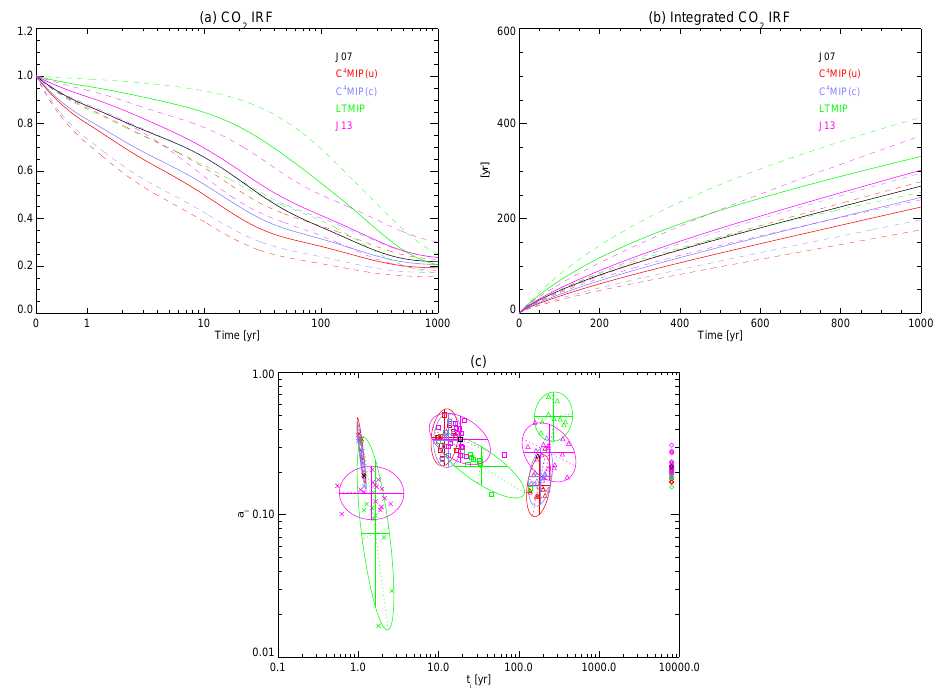
Fig. 1. Overview of five different IRF CO 2 distributions: J07 (black), C 4 MIP(u) (red), C 4 MIP(c) (blue), LTMIP (green), and J13 (purple). (a) IRF CO 2 as in Eq. (1) with median (full line) and 5- and 95-percentile values (dashed lines) indicated. The horizontal axis is linear from 0 to 1yr, and logarithmic from 1 to 1000yr. The vertical axis is dimensionless. (b) Integrated IRF CO 2 . The horizontal axis is linear. (c) Estimates for the parameters in IRF CO 2 . Every single dot corresponds with one of the four modes, i.e. ( τ 0 ,a 0 ) (diamond), ( τ 1 ,a 1 ) (triangle), ( τ 2 ,a 2 ) (square), or ( τ 3 ,a 3 ) (cross). The ( τ 0 ,a 0 ) tuples (which would fall off the figure as τ 0 = ∞ ) are given at the right of the figure. The individual dots represent the best estimates for the individual CC-models, while the ellipses represent the distributions derived from the individual estimates, grouped per inter-comparison exercise. Inside the ellipses falls 90% of the distribution. The vertical axis is dimensionless.